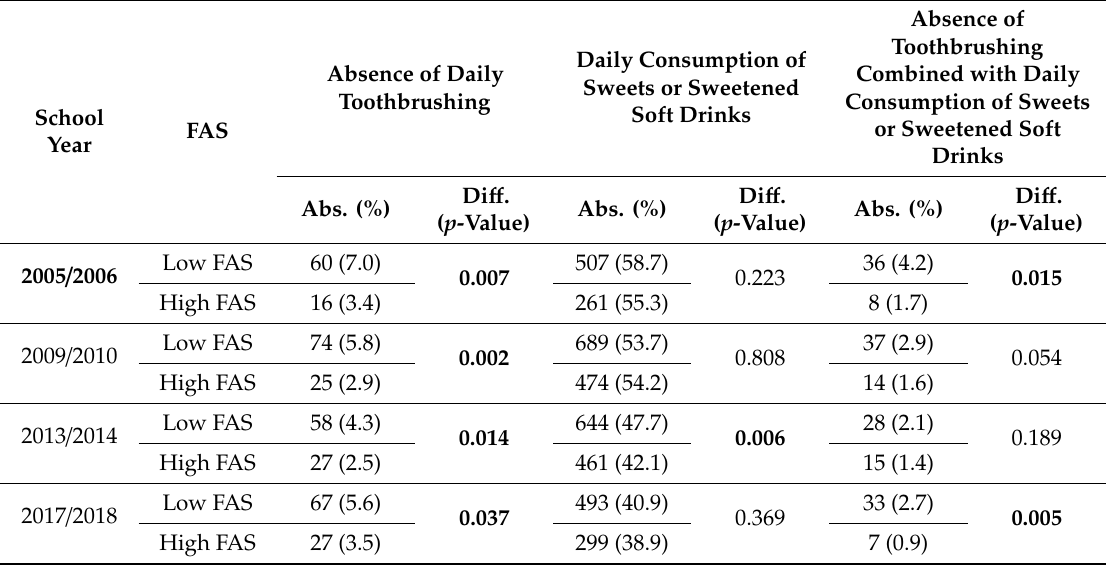
Table 4. Prevalence of the selected risk factors of caries by socioeconomic status in 11-13-year-old girls.